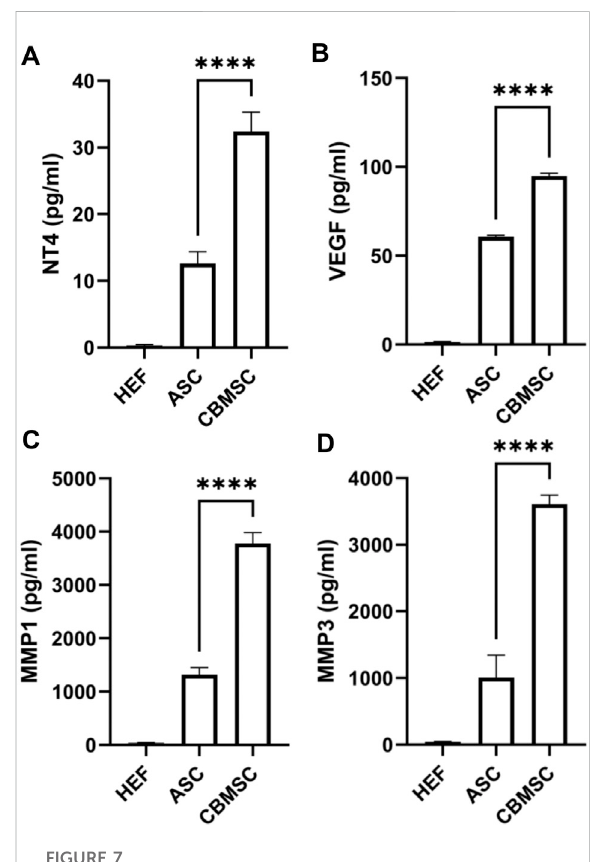
FIGURE 7 Quantitative analysis of NT4, VEGF, MMP1, and MMP3 levels of CBMSC-CM. The levels of NT4 (A) , VEGF (B) , MMP1 (C) , and MMP3 (D) from HEF-CM, ASC-CM, and CBMSC-CM were detected by ELISA